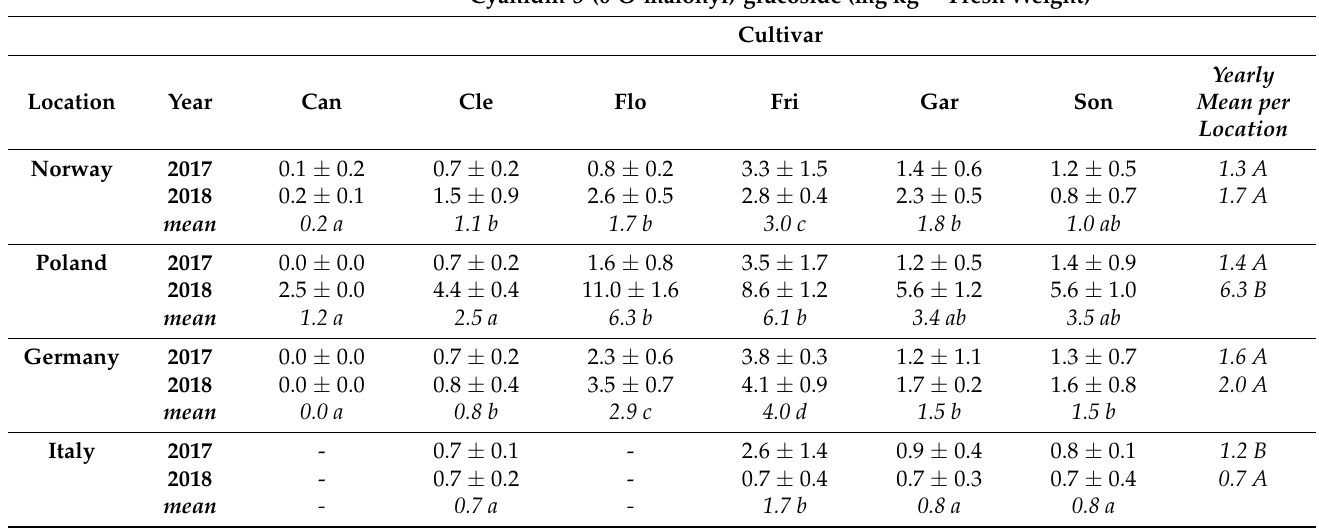
Table 6. Effect of growing location and year on cyanidin-3-(6-O-malonyl)-glucoside content as the mean of two picking dates in fruits of six strawberry